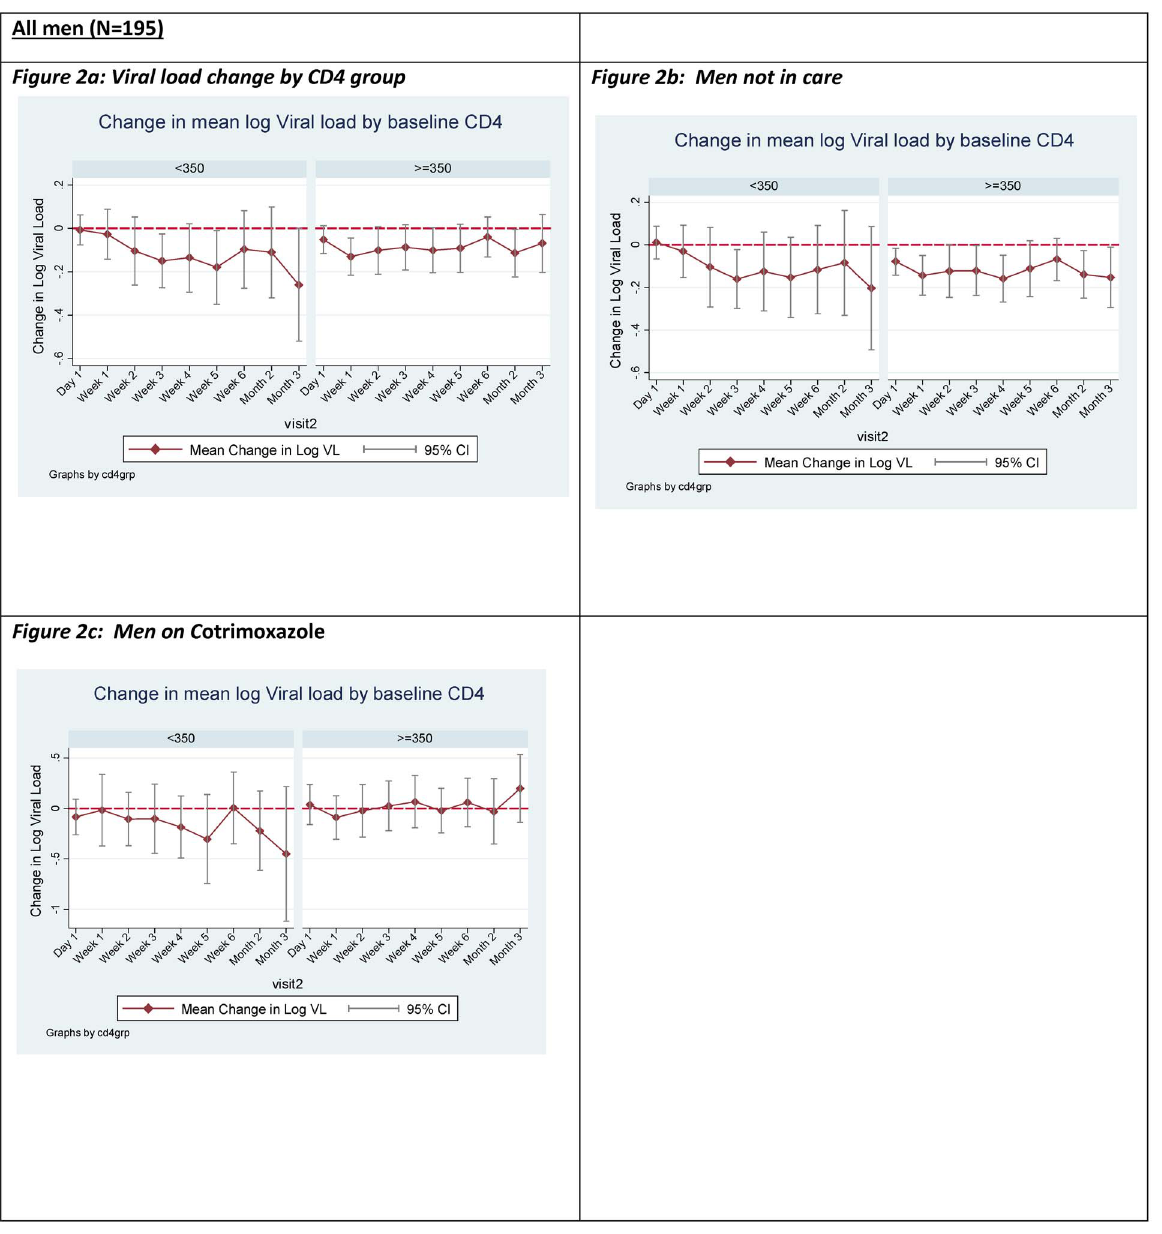
Figure 2. Graphs of mean differences in log 10 viral load relative to baseline by follow-up visit.